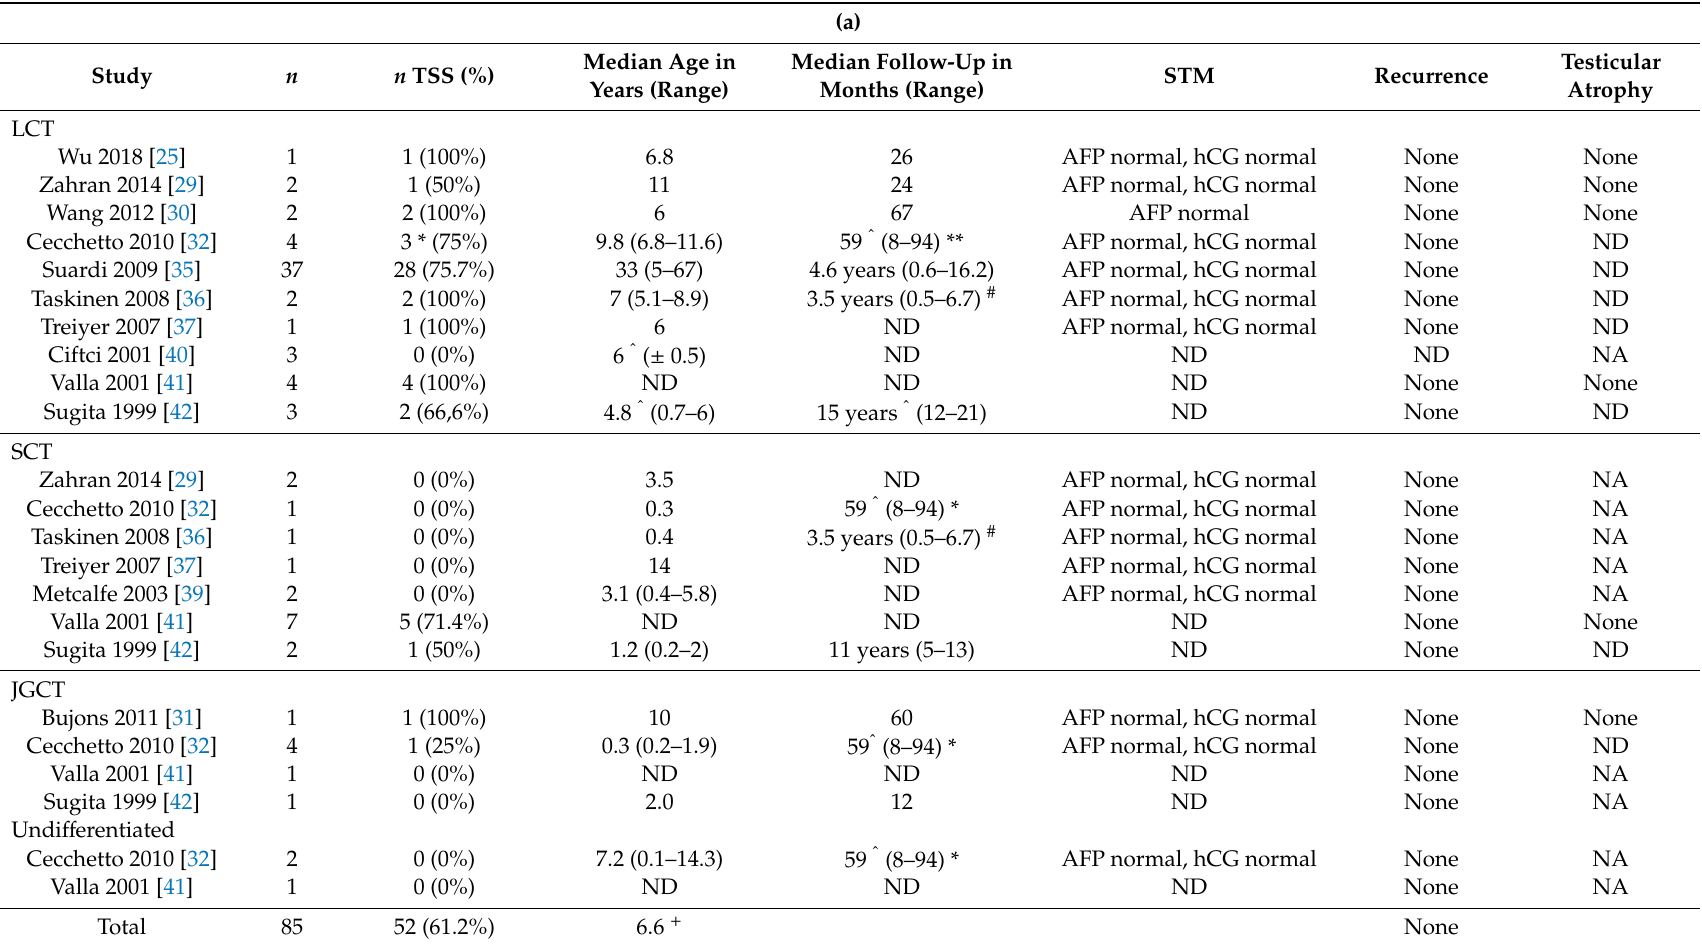
Table 3. ( a ) TSS in testicular sex cord-stromal tumors. ( b ) TSS in miscellaneous testicular